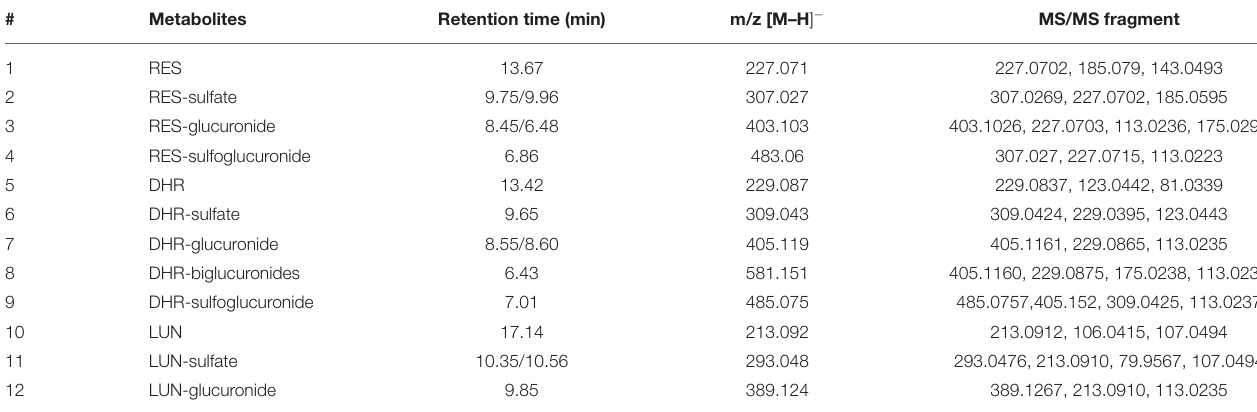
TABLE 1 | Metabolites of resveratrol were identified with high-resolution HPLC-MS/MS in the